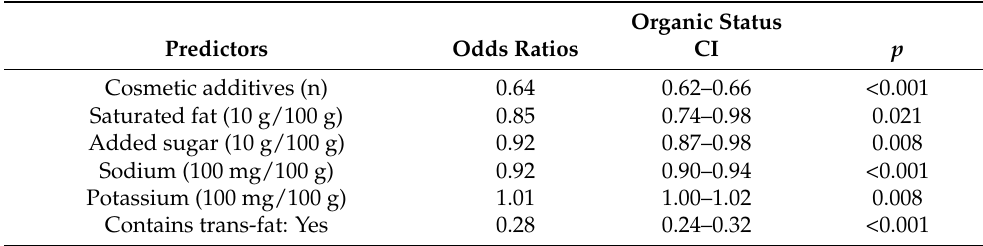
Table 6. Results from mixed logistic regression model of 3661 organic and 28,596 conventional products that had complete nutritional information for parameters included in this model. This model included the parameter “cosmetic